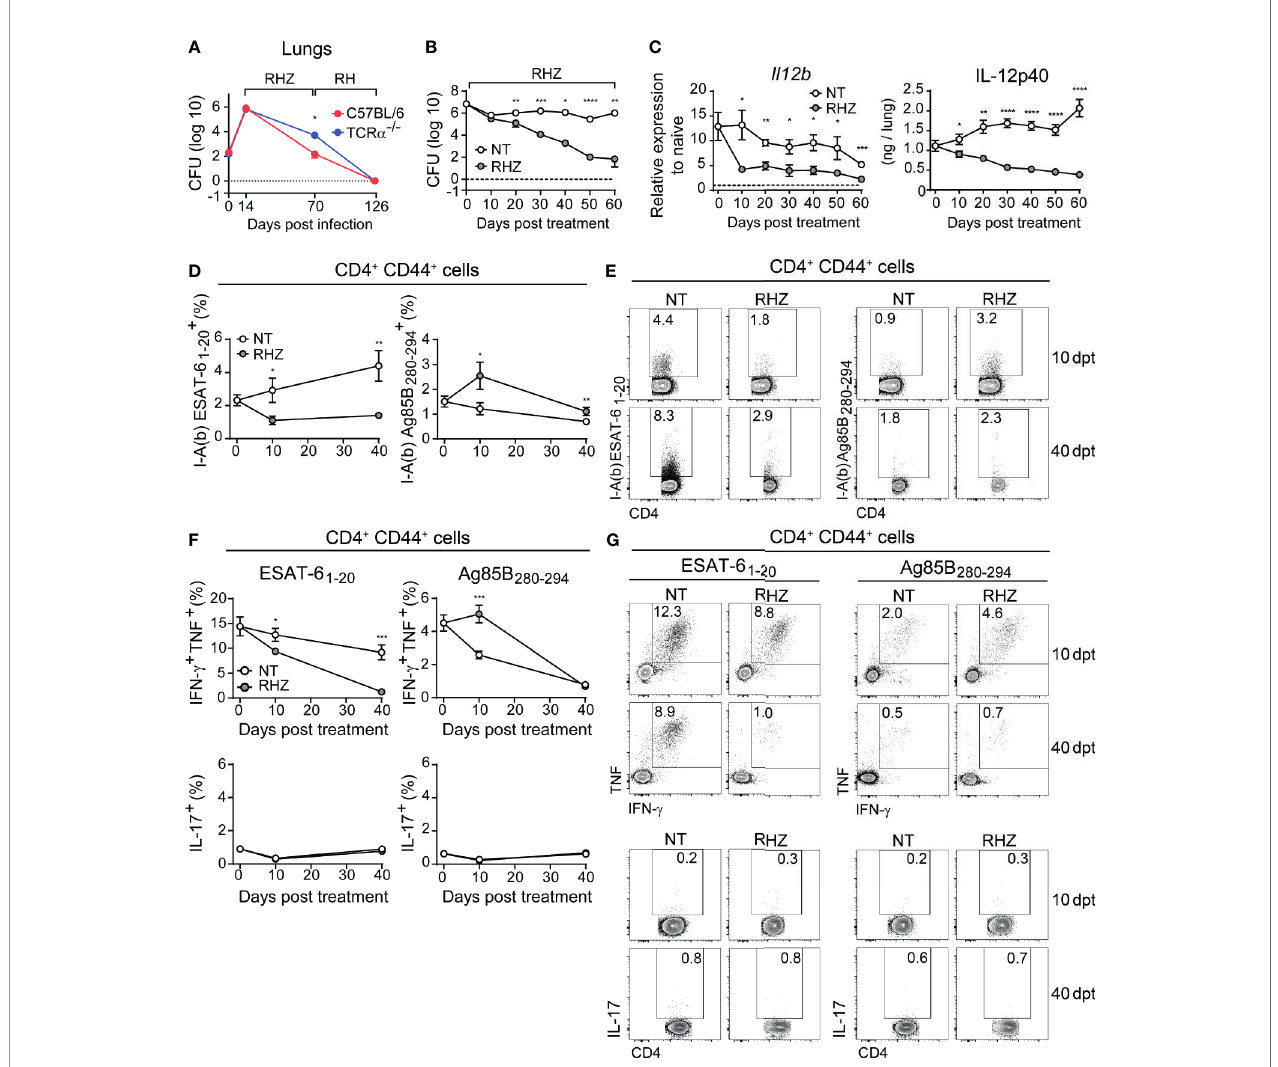
FIGURE 1 | Antibiotic treatment of Mtb-infected mice results in rapid decrease in pulmonary IL-12p40 production and ESAT-6-speci fi c Th1 response. (A) C57BL/6 (red dots and line) or TCR a -/- (blue dots and line) mice were infected with 100 CFU of M. tuberculosis strain H37Rv and then treated, starting at 14 days post- infection (dpi), with a cocktail containing rifampicin (10 mg/kg), isoniazid (25 mg/kg) and pyrazinamide (150 mg/kg) (RHZ) for the fi rst 56 days, followed by a continuation phase in which mice received only rifampicin (10 mg/kg), isoniazid (25 mg/kg) until 126 dpi. Graph shows pulmonary bacterial loads 70 dpi (56 days post-treatment - dpt) and 126 dpi (112 dpt); (B – G) C57BL/6 mice were infected with 100 CFU of M. tuberculosis strain H37Rv and then treated or not, starting at 28 dpi (day 0 post-treatment), with a cocktail containing rifampicin (10 mg/kg), isoniazid (25 mg/kg) and pyrazinamide (150 mg/kg) (RHZ); (B) Pulmonary bacterial loads in non-treated (NT – white dots) and antibiotic treated (RHZ – gray dots) Mtb-infected mice at 0, 10, 20, 30, 40, 50 and 60 dpt; (C) IL-12p40 mRNA expression (left panel) and protein quanti fi cation (right panel) in lung homogenates of non-treated (NT – white dots) or antibiotic treated (RHZ – gray dots) Mtb- infected mice at 0, 10, 20, 30, 40, 50 and 60 dpt; (D) Graphs and (E) representative dot plots depicting frequencies of ESAT-6 and Ag85B - speci fi c CD4 + CD44 + T lymphocytes (Singlets/Live/TCR b + CD4 + /Foxp3 - /CD44 + /tetramer + ) in lungs of NT or RHZ treated Mtb-infected mice, 10 and 40 dpt; (F) Graphs and (G) representative dot plots depicting IFN g and TNF double producing and IL-17-producing pulmonary CD4 + CD44 + T lymphocytes (Singlets/Live/TCR b + CD4 + /Foxp3 - / CD44 + /IFN g + TNF + or IL-17 + ) after ex vivo stimulation with ESAT-6 or Ag85B peptides in NT or RHZ treated Mtb-infected mice, at 10 and 40 dpt. Representative data of 2 independent experiments containing 4-5 mice/group are shown. Results are expressed as mean ± standard error of mean (A – D, F) and dot plots from fl ow cytometry concatenated data (E, G) . Statistical analysis: unpaired Student ’ s t test. *p ≤ 0.05, **p ≤ 0.01, ***p ≤ 0.001, ****p ≤